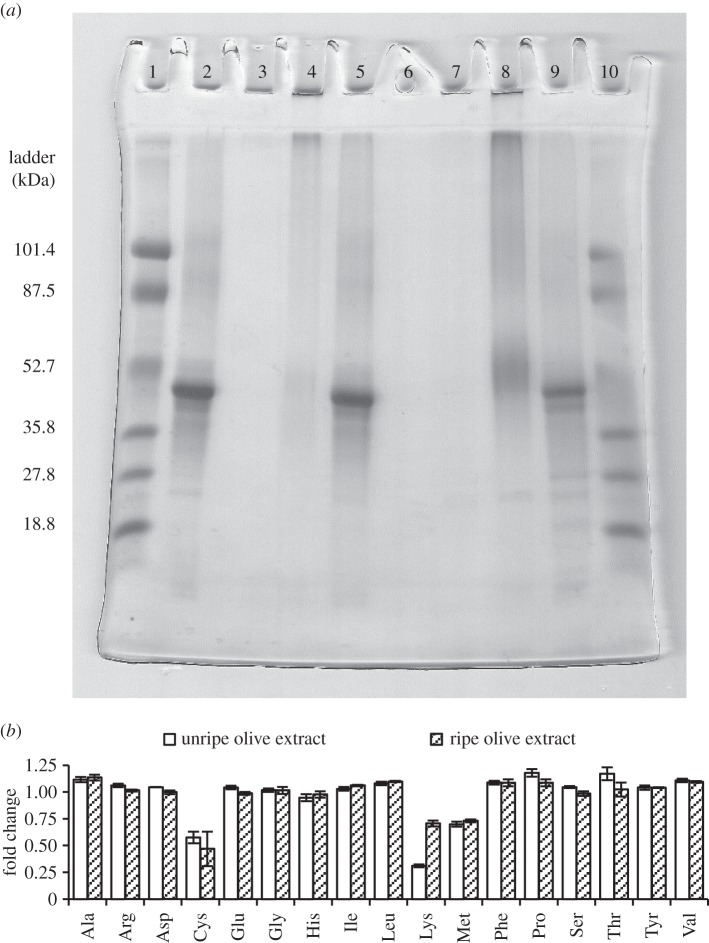
Protein cross-linking and lysine-decreasing activities in unripe and ripe ‘Souri’ olives. (a) SDS-PAGE analysis demonstrating the separation pattern of ovalbumin, either native (lane 2) or incubated in unripe (lane 4) or ripe (lane 8) olive extracts. Protein cross-linking associated with the unripe fruit (nearly no protein entered the gel) was reduced in ripe olives (substantial protein quantities visualized). In the presence of glycine, the modification of ovalbumin was prevented (lanes 5 and 9: unripe and ripe fruit, respectively). Crude extracts of unripe and ripe fruit (no ovalbumin or glycine added) contained very little protein (lanes 3 and 7, respectively). Lanes 1 and 10 were loaded with a protein size marker (‘low range’ standards; BioRad, USA). Lane 6 is empty. (b) Fold change in the amino acid content of ovalbumin (μmol mg−1 protein) after treatment in unripe (open bars) and ripe (shaded bars) ‘Souri’ olive extracts, as determined by HPLC quantitation (triplicate readings in each group). Lysine content was substantially reduced by unripe fruit extract.